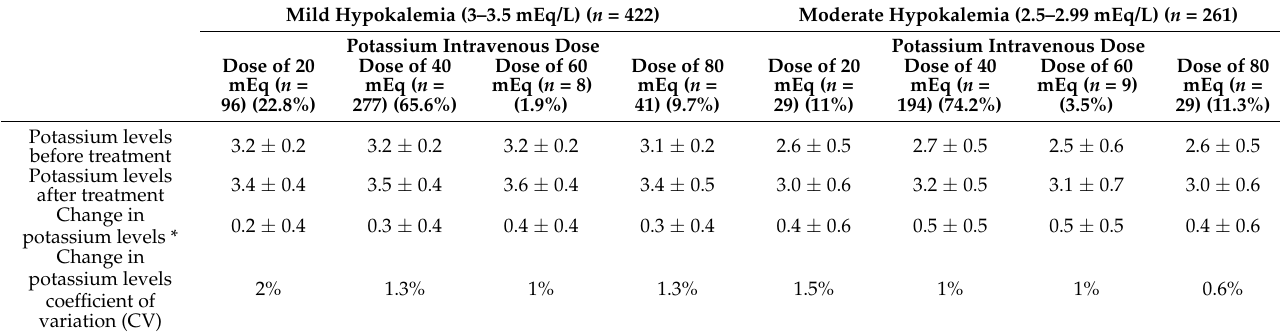
Table 3. Potassium lab results and treatment